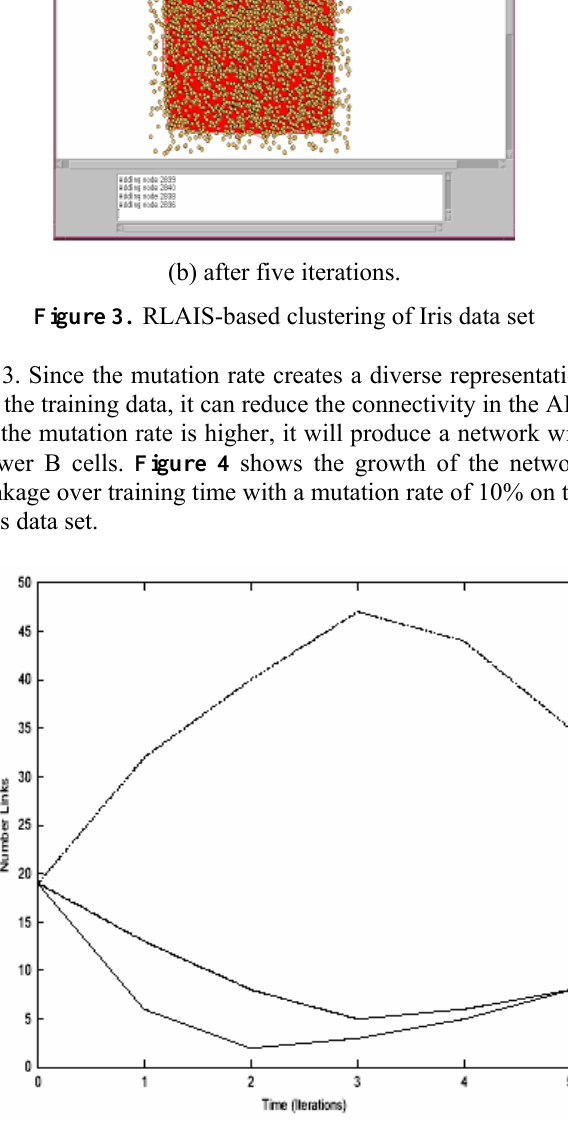
Figure 4. Linkage growth with mutation rate of 10% on Iris data